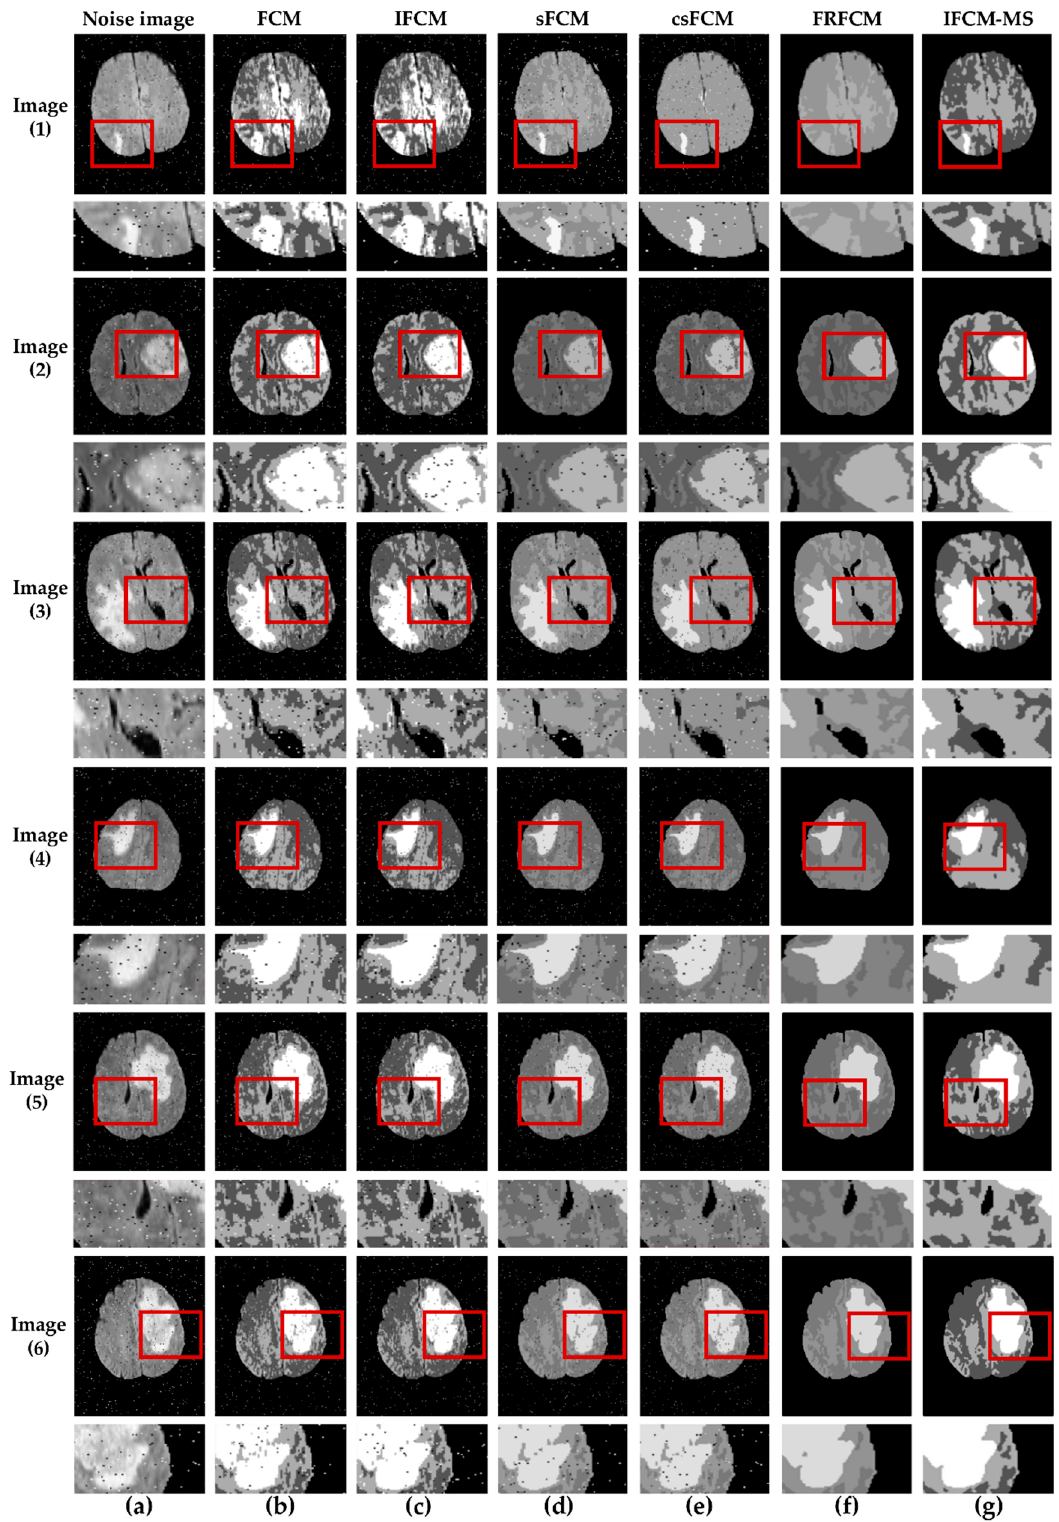
Figure 3. Segmentation results of noisy images (all the areas marked by red squares were enlarged and placed below the corresponding image). ( a ) Noise image. ( b ) FCM. ( c ) IFCM. ( d ) sFCM: spatial fuzzy C-means clustering algorithm. ( e ) csFCM: conditional spatial fuzzy C-means clustering algorithm. ( f ) FRFCM: FCM algorithm based on membership function filtering. ( g ) IFCM-MS.